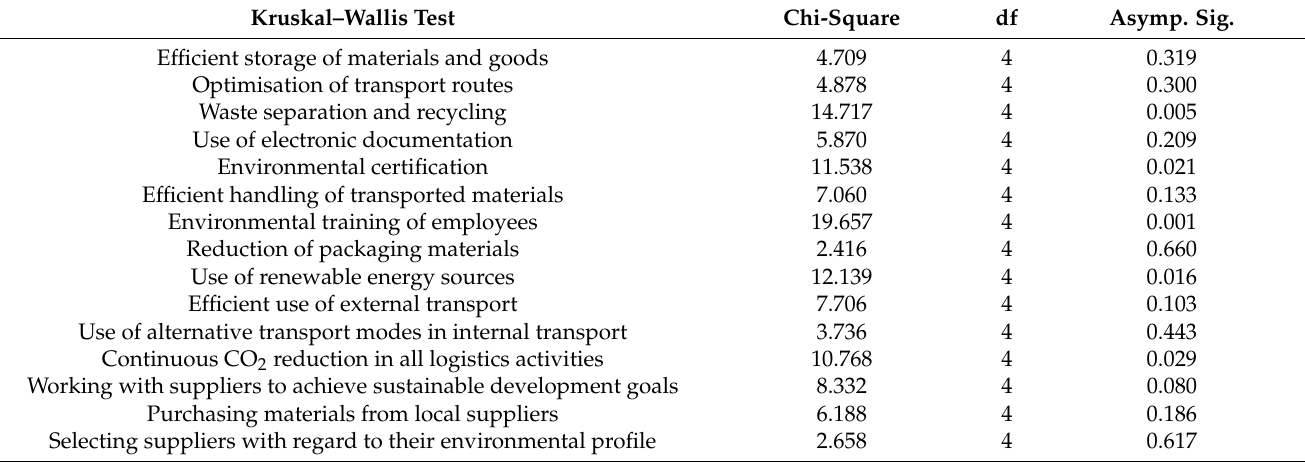
Table 6. Evaluation of null and alternative research